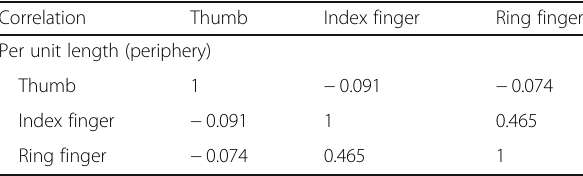
Table 3 Correlation between Thumb, Index, and Ring finger per unit length for periphery position Correlation Thumb Index finger